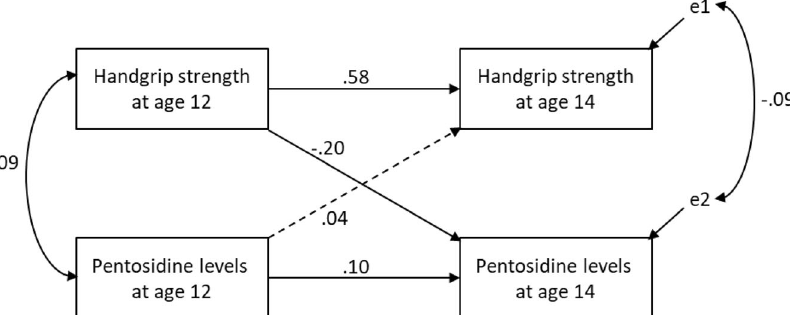
Fig. 1 Cross-lagged panel model showing the direction of association between handgrip strength and pentosidine levels. Note: Solid black line, path coef fi cient is statistically signi fi cant ( p < 0.05); dotted line, path coef fi cient is not signi fi cant ( p ≥ 0.05).